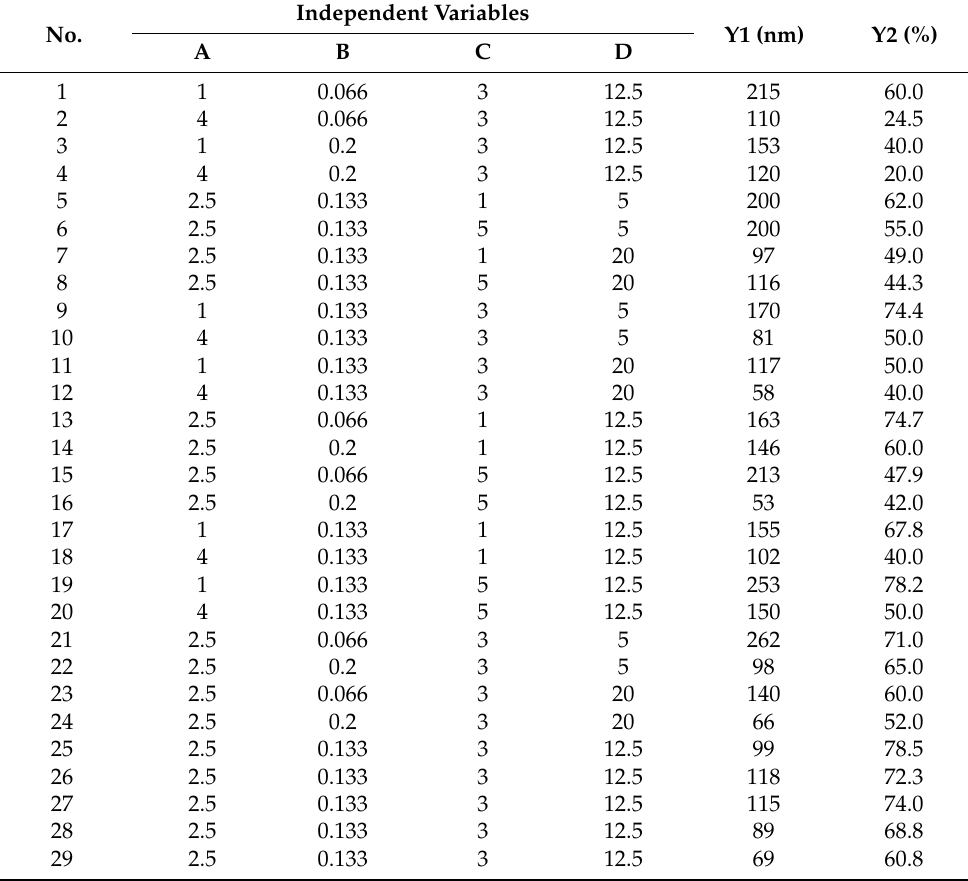
Table 1. Response surface methodology experimental design for CPDNL preparation.